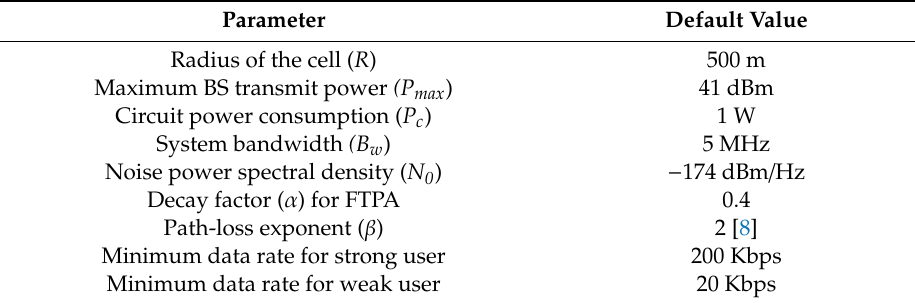
Table 4. Parameter specifications [28].